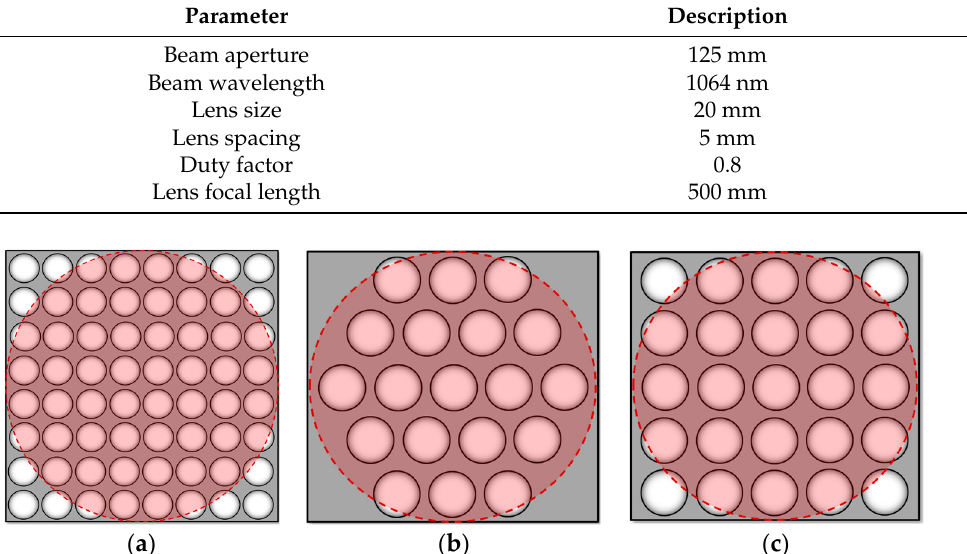
Table 1. System input parameters.